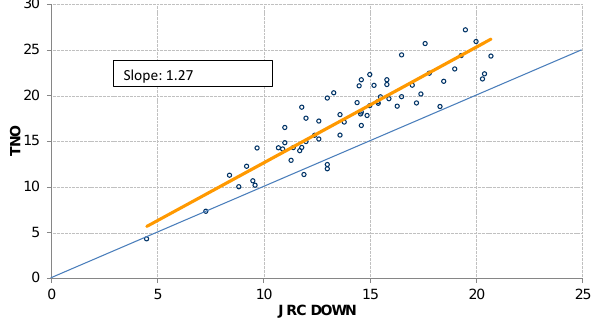
Figure 4. Comparison of NO x emission rates (g NO 2 kWh − 1 ) de- termined by “sniffer” measurements (see text), assuming an engine fuel efficiency of 185gkWh − 1 . Regression lines, forced through (0 , 0) have been obtained by orthogonal regressions. Three outliers have been